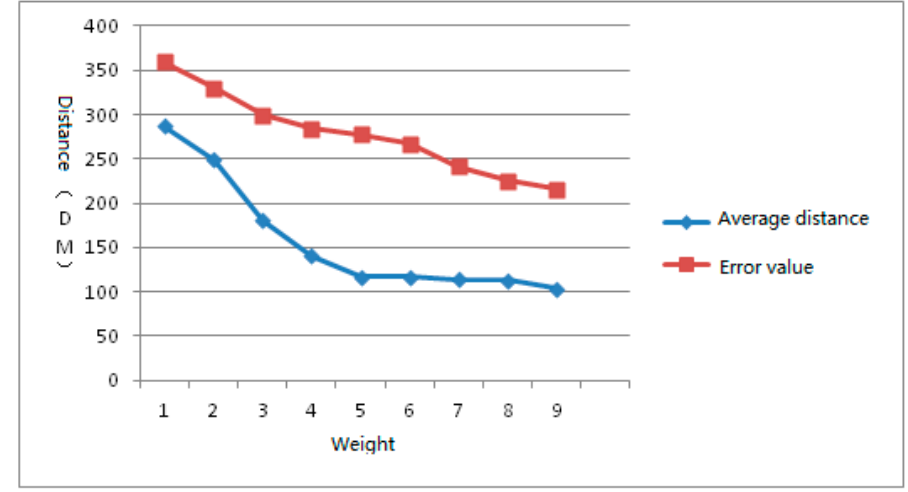
Figure 15. The average distance between the three nearby APs and error statistics of the sample points.